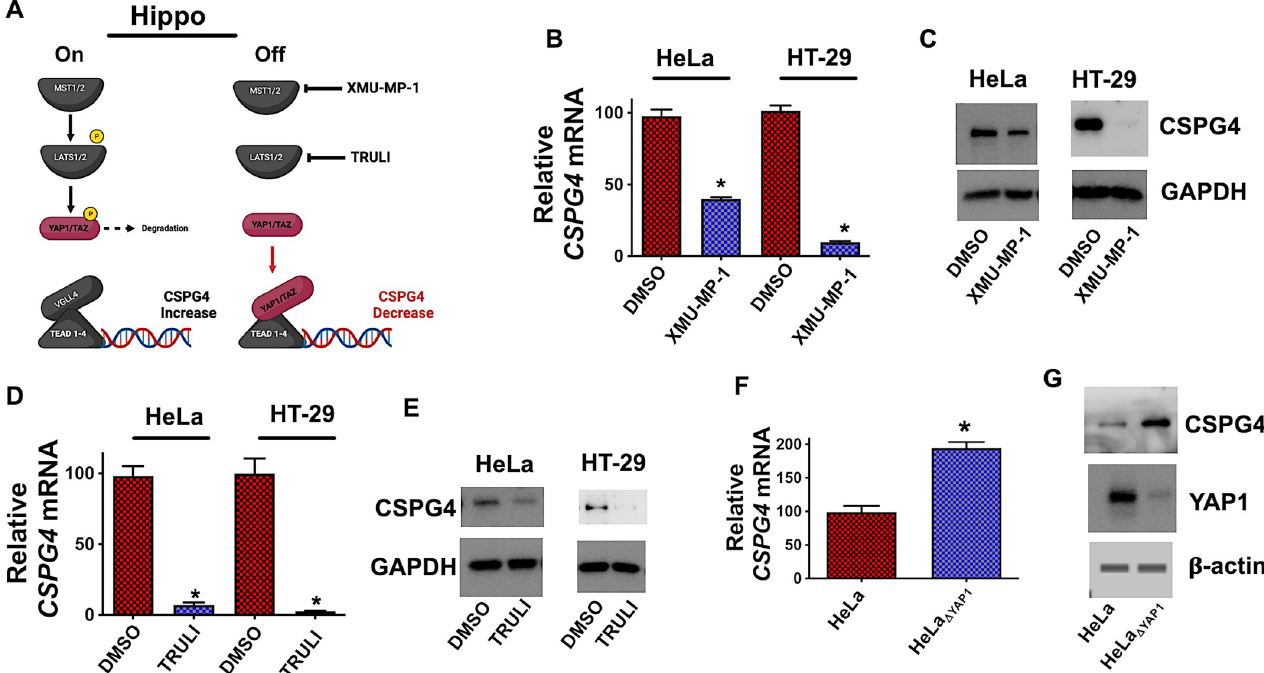
Fig 4. Hippo signaling regulates CSPG4 levels. ( A ) Depiction of the Hippo signaling pathway and the effect of inhibition by XMU-MP-1 and TRULI. ( B ) CSPG4 transcript levels in HeLa and HT-29 cells treated with 3 μ M XMU-MP-1 for 7 h. CSPG4 transcript levels are presented as mean (n = 3) ± S.D. ( C ) Immunoblot detection of CSPG4 from HeLa and HT-29 cells exposed to 6 μ M of XMU-MP-1 for 24 h. ( D ) CSPG4 transcript levels in HeLa and HT-29 cells treated with 30 μ M TRULI for 24 h. CSPG4 transcript levels are presented as mean (n = 3) ± S.D. (E) Immunoblot detection of CSPG4 from HeLa and HT-29 cells exposed to 30 μ M of TRULI for 24 h. ( F ) CSPG4 transcript levels in HeLa and YAP1 knock out cells (HeLa Δ YAP1 ). CSPG4 transcript levels are presented as mean (n = 3) ± S.D. ( G ) Immunoblot analyzing YAP1 and CSPG4 levels in HeLa cells and HeLa Δ YAP1 . * p < 0.05 determined by Student’s